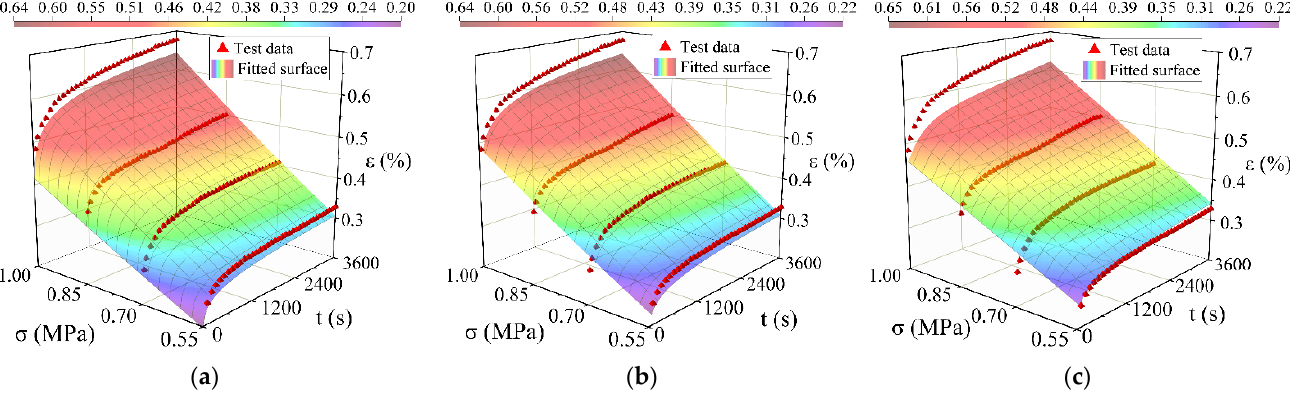
Figure 9. Comparison between test data points with the different model fitted surfaces at 40 °C: ( a ) Fitting result of the time hardening model; ( b ) Fitting result of the modified time hardening model; ( c ) Fitting result of the modified Burgers model.